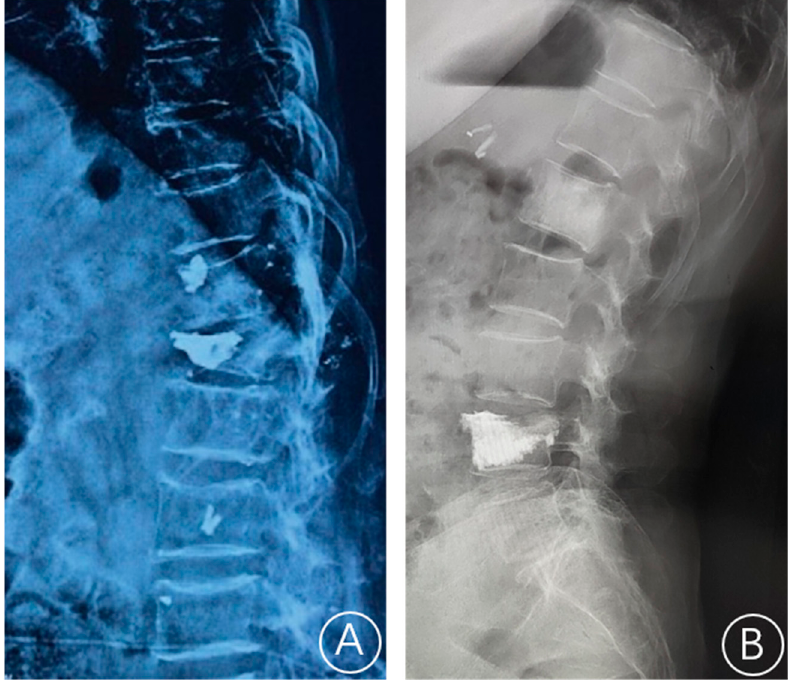
Figure 1. A plain radiograph showed whether the bone cement is displaced. ( A ) Bone cement displacement. ( B ) Non-bone cement displacement.